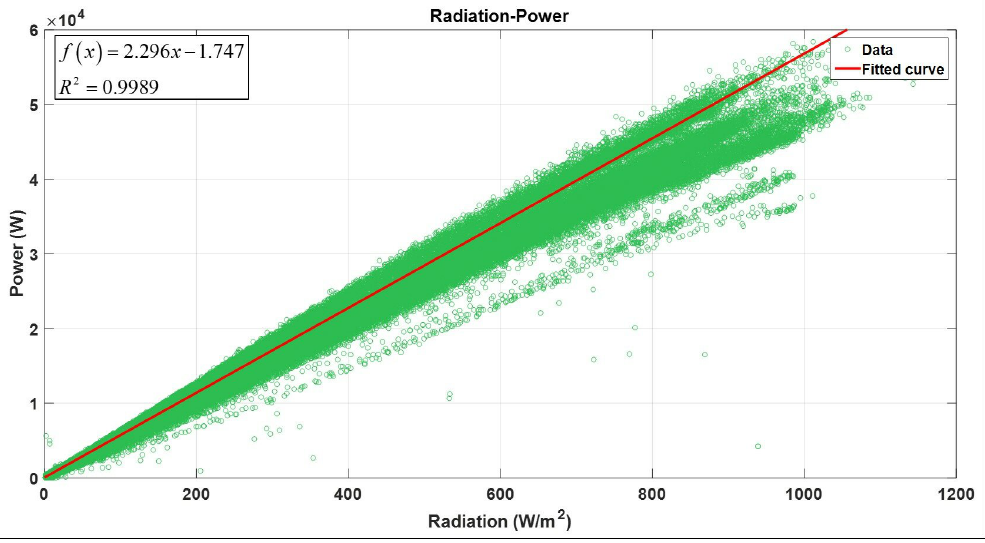
Figure 11. The Power vs. Solar radiation of